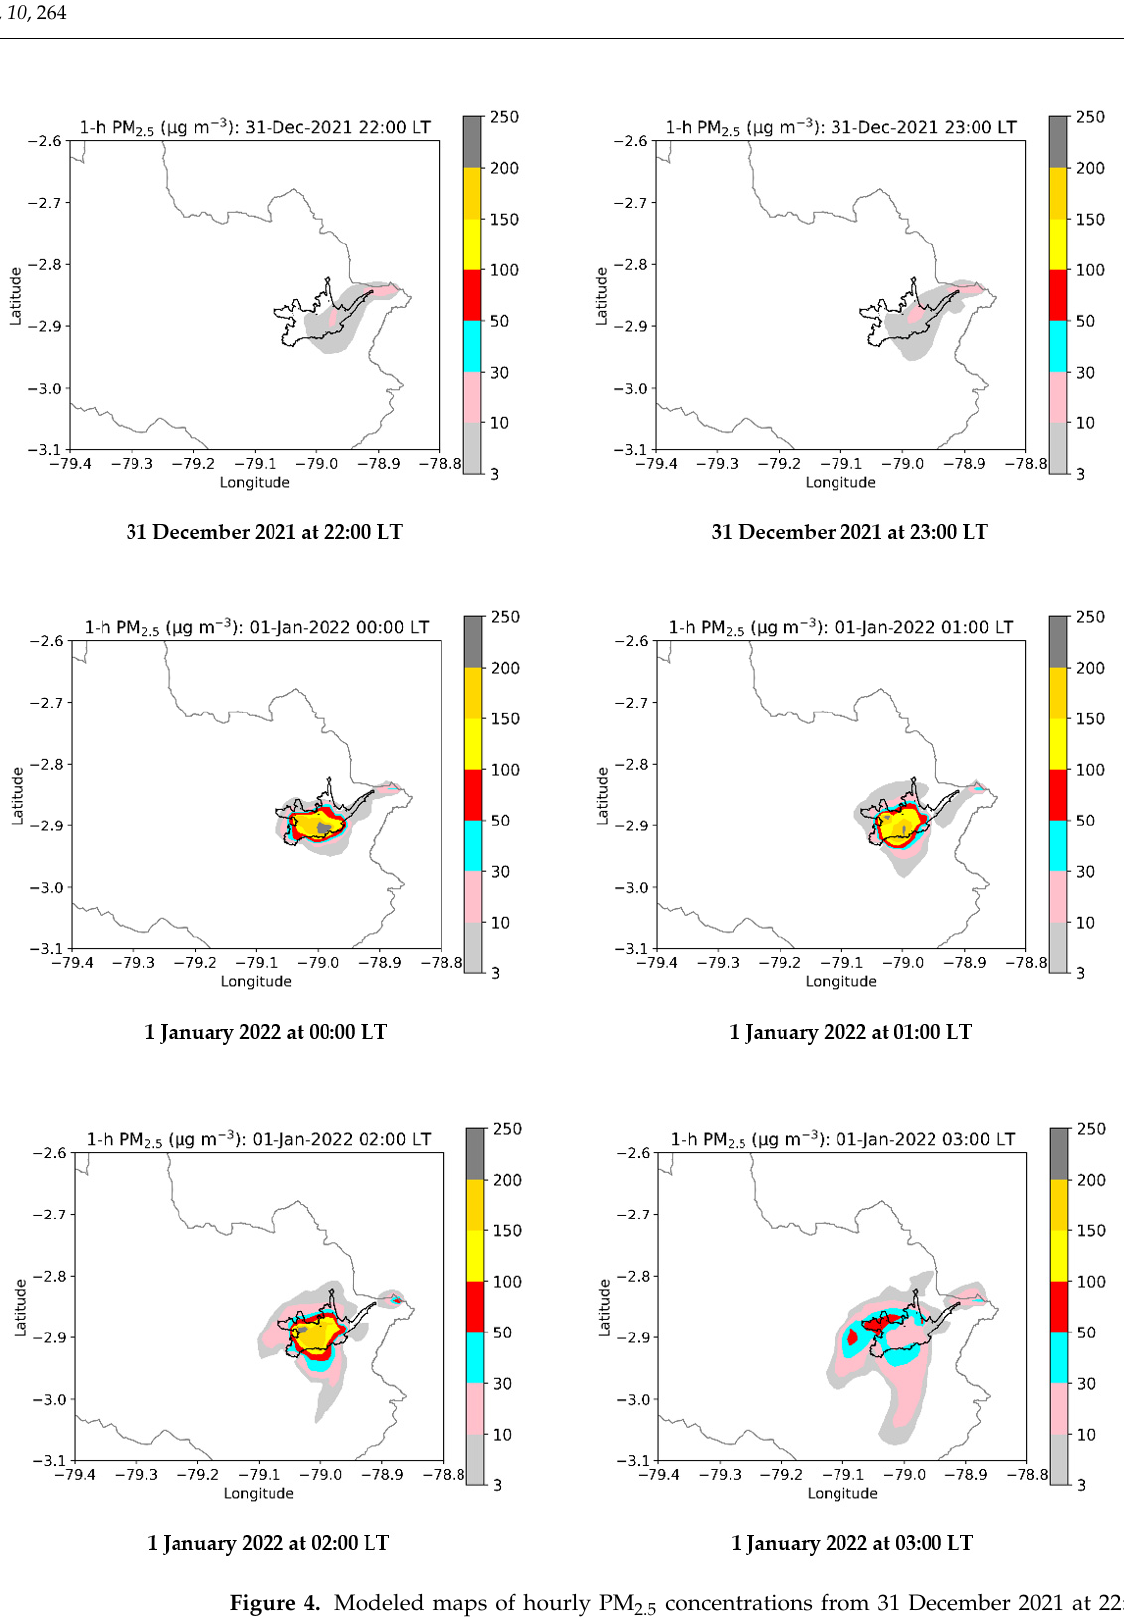
Figure 4. Modeled maps of hourly PM 2.5 concentrations from 31 December 2021 at 22:00 LT to 1 January 2022 at 03:00 LT. Reference scenario: New Year’s emissions beginning on 1 January 2022 at 00:00 LT.